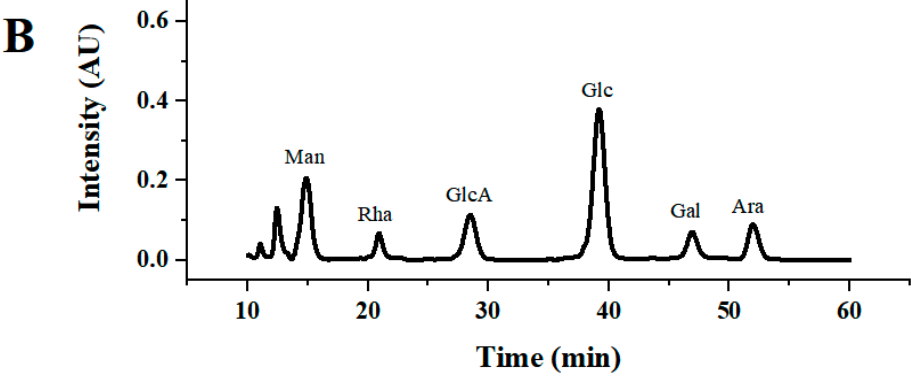
Figure 2. ( A ) HPGPC chromatograms of DLP-3; ( B ) monosaccharide composition of DLP-3.